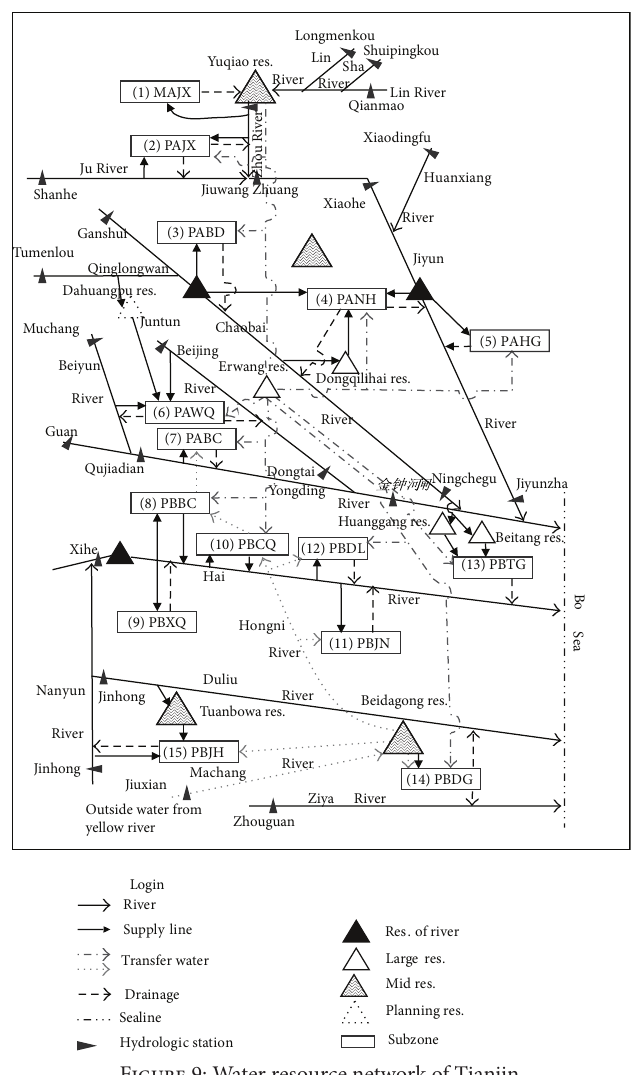
Figure 9: Water resource network of